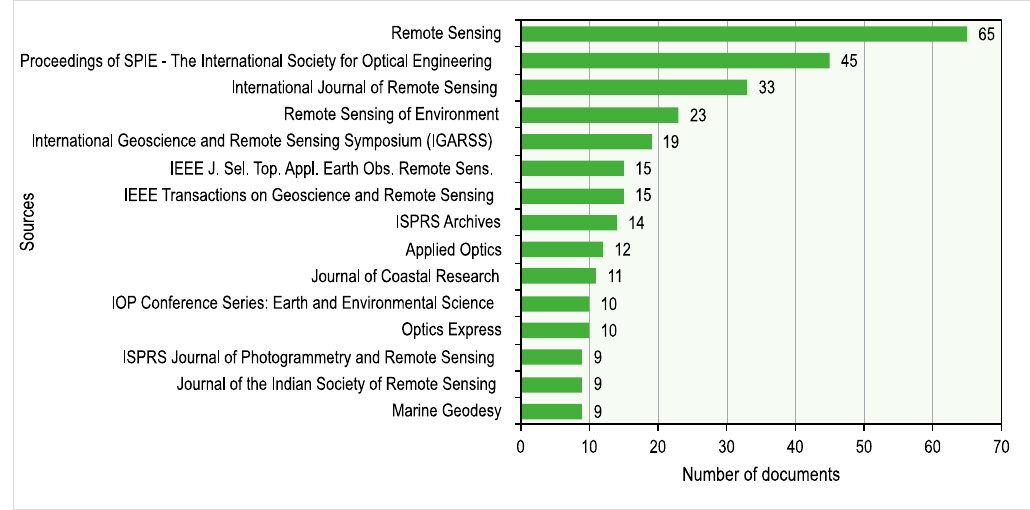
Figure 6. Fifteen most relevant sources from the unified WoS and Scopus databases.